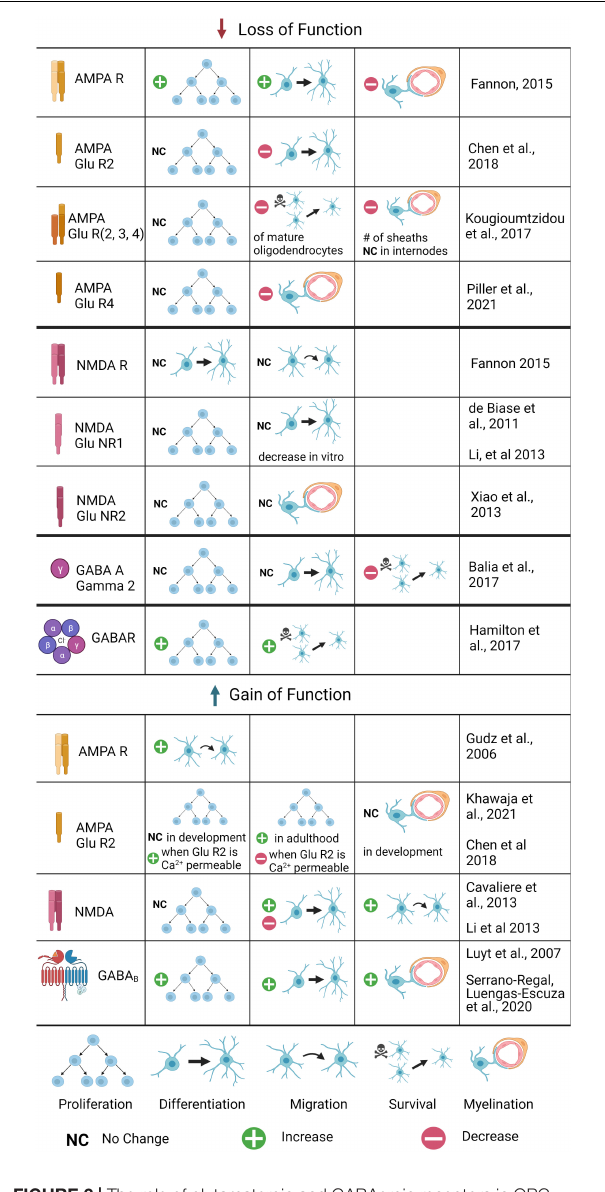
FIGURE 2 | The role of glutamatergic and GABAergic receptors in OPC development and myelination: Summary of Gain and Loss of Function Experiments. Changes in OPC proliferation, differentiation, migration, or survival are included, as well as changes in myelination. Loss of function experiments have been conducted for several AMPA and NMDA receptor subunits, as well as the GABAA γ 2 subunit; gain of function experiments are limited to AMPA, AMPA GluR2, NMDA, and GABAB experiments. Where the process was tested but no differences found, no change is noted; if the process was untested it is not included for that receptor. Where conflicting results were found, both are